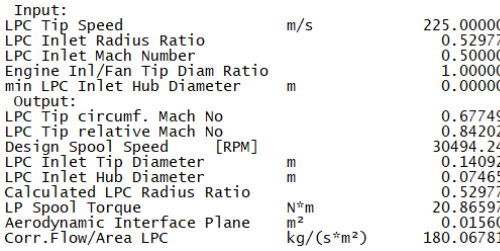
Figure A5. GasTurb model LPC design parameters.